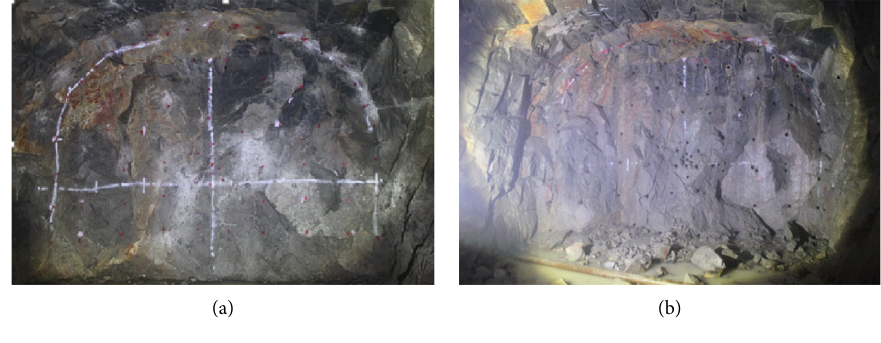
Figure 4: Borehole